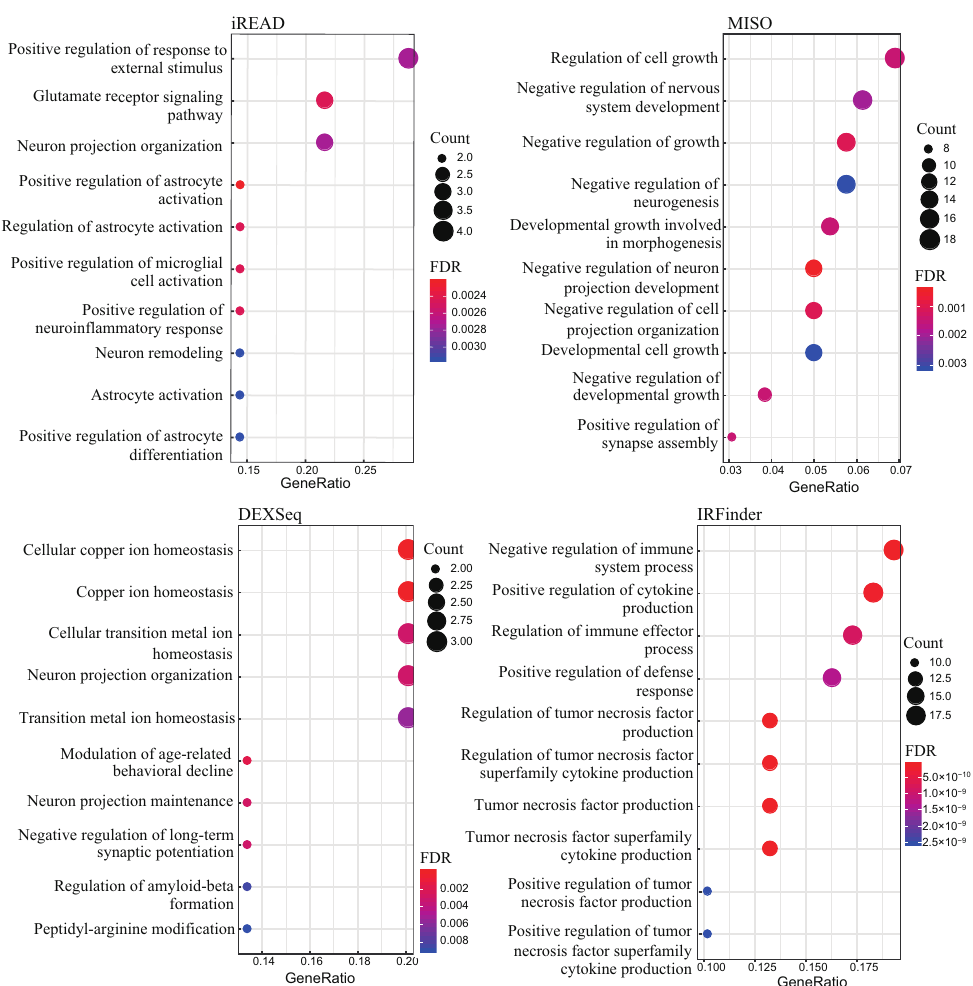
Fig. 7 Top 10 GO enrichment results for rMATS, IRFinder, iREAD, and DEXSeq, where GeneRatio indicates the proportion of genes containing the GO term. Circle size represents the number of genes or gene products annotated by GO terms. The more reddish the color, the more significant the enrichment.